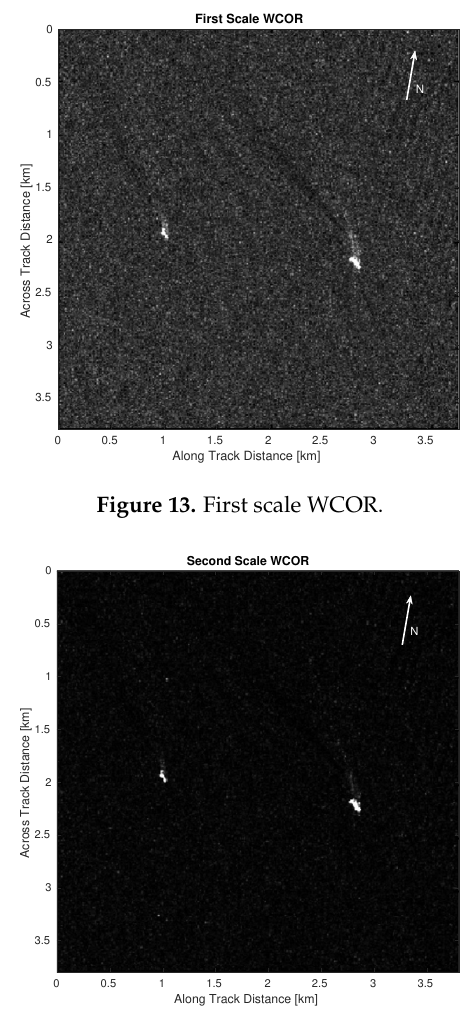
Figure 14. Second scale WCOR, ships